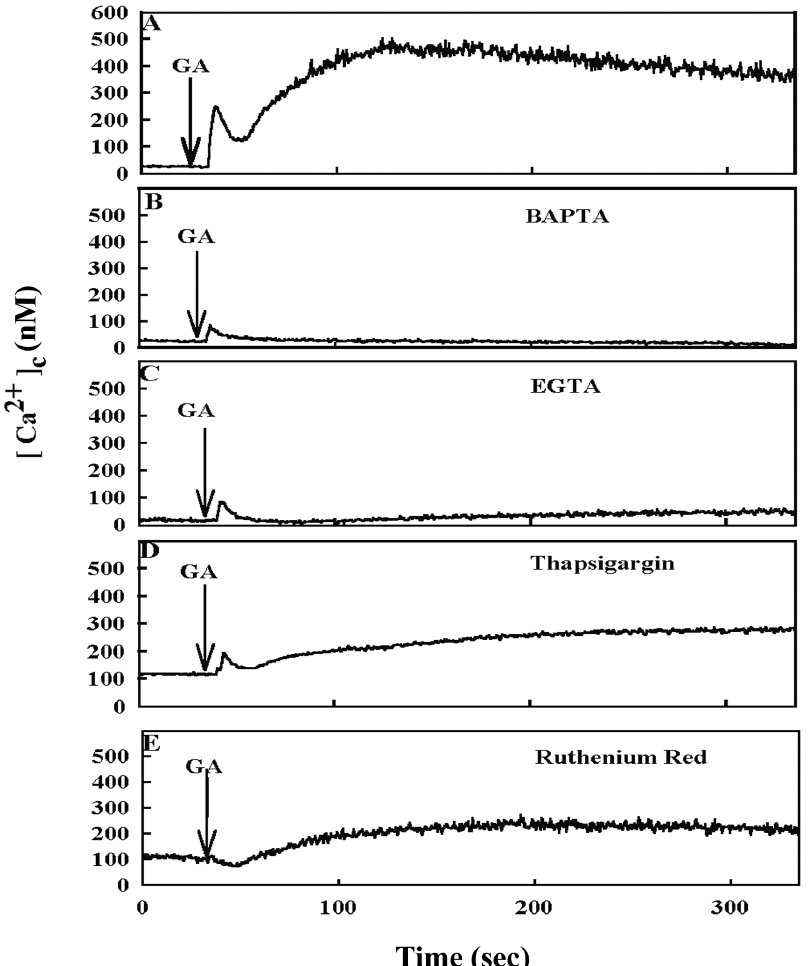
Figure 2. Effects of BAPTA/AM, EGTA, thapsigargin and ruthenium red on GA-induced intracellular calcium concentration. Cells were loaded with indo-1/AM. GA only as control ( A ) or preincubated with 15 µM BAPTA-AM ( B ); 1 mM EGTA ( C ); 300 nM thapsigargin (TG) ( D ); or 50 µM ruthenium red (RR) ( E ) for 20 min and, then, stimulated with GA at time 0. Changes in [Ca 2+ ] were determined by fluorescence c